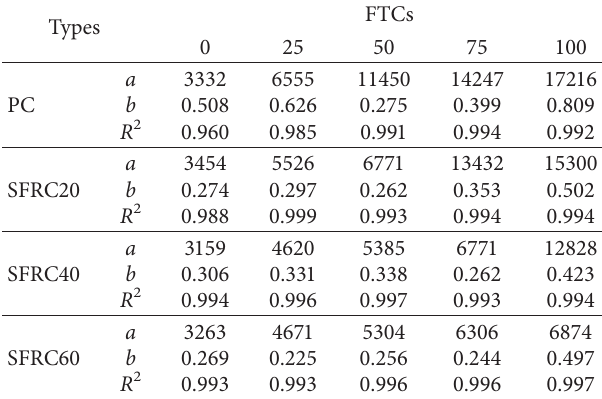
Table 7: Fitting results of CWA with square root of time.